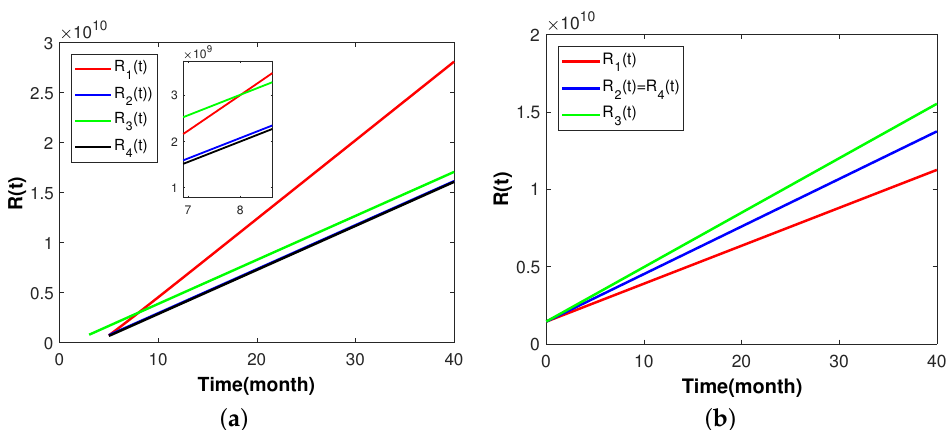
Figure 7. Optimal strategies’ results about profits. In order to make the results clearer, we enlarged Figure 7a. ( a ) Optimal strategies’ results of profits based on the first group of parameters. ( b ) Optimal strategies’ results of profits based on the second group of parameters.